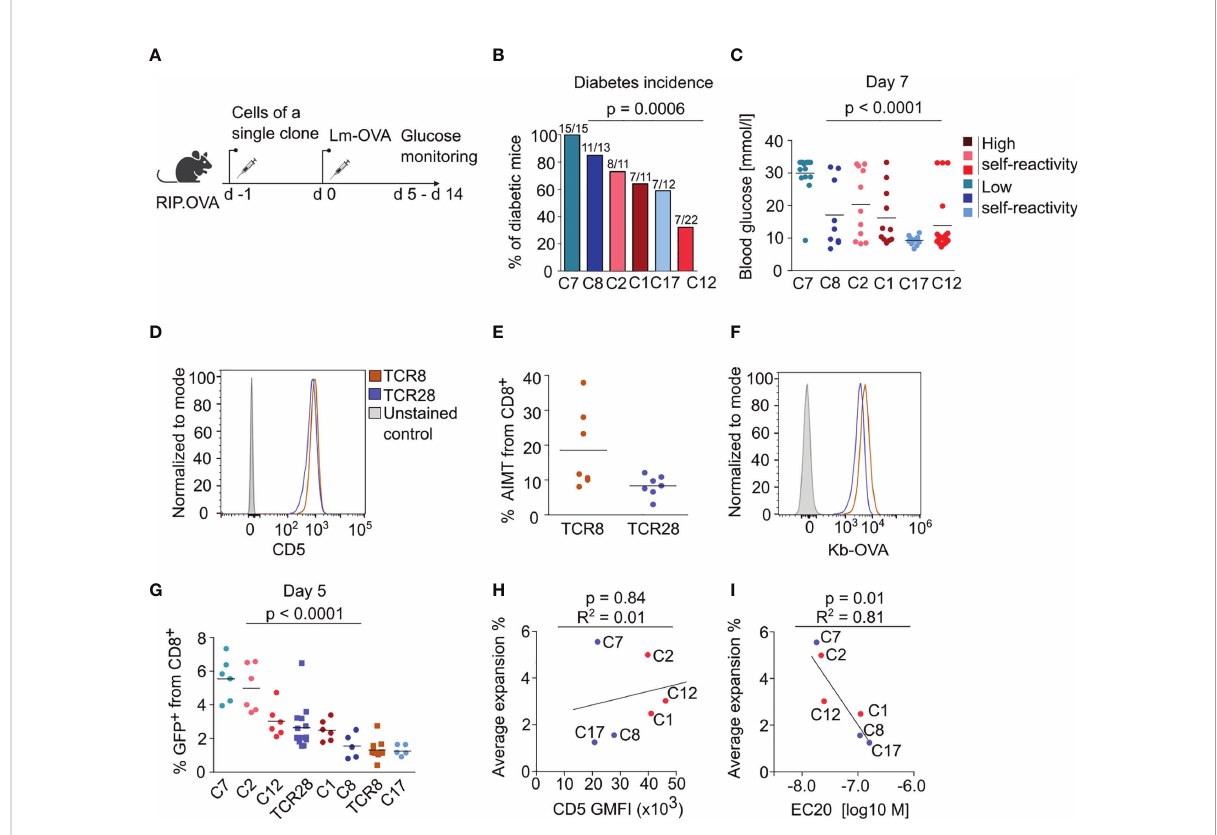
FIGURE 3 The self-reactivity does not dictate the magnitude of immune response of naïve CD8 + T cells. (A-C) 10 4 CD8 + T cells from the indicated clone were transferred into RIP.OVA mice. The next day, mice were infected with Lm-OVA. Urine glucose levels were monitored on a daily basis on days 5-14 post infection. (A) Scheme of the experiment. (B) Percentage of the diabetic mice is shown. Number of the diabetic mice and total number of mice per group is indicated on top of each column. Three (C1, C2, C8, C17) or four (C7, C12) independent experiments. For the incidence of diabetes over time, see Figure S3B. (C) Glucose concentration in blood on day 7 post-infection. Mean. Clone 1: n=11, Clone 2: n= 11, Clone 7: n=15, Clone 8: n=13, Clone 12: n=22, Clone 17: n=12. (D – F) Phenotypic analysis of two additional monoclonal TCRs reactive to OVA, TCR8 and TCR28. Splenocytes and LN cells were isolated from sub-lethally irradiated Ly5.1 mice transplanted with the indicated clones and CD8 + T cells were analyzed by fl ow cytometry. (D) Expression of CD5 in CD8 + LN cells. A representative experiment out of three in total. (E) Percentage of AIMT (CD44 + CD49 - ) T cells among CD8 + splenocytes. Mean. n = 5 mice per group from two independent experiments. (F) Staining of monoclonal LN cells with fl uorescently labeled K b -OVA tetramer. A representative experiment out of three in total. (G) Monoclonal naïve (CD44 - ) CD8 + T cells were sorted from LN cells and adoptively transferred to polyclonal Ly5.1 host mice (10 000 cells/mouse), which were infected one day later with transgenic Lm-OVA. Five days after the infection, the percentage of adoptively transferred GFP + T cells among all CD8 + T cells was determined by fl ow cytometry. Mean. n = 6-12 per group from three independent experiments. The statistical signi fi cance was calculated using the Kruskall-Wallis test. (H, I) A linear fi t between average expansion and (H) CD5 gMFI or (I) EC20 of the tetramer staining. The Pearson correlation coef fi cient and p value is